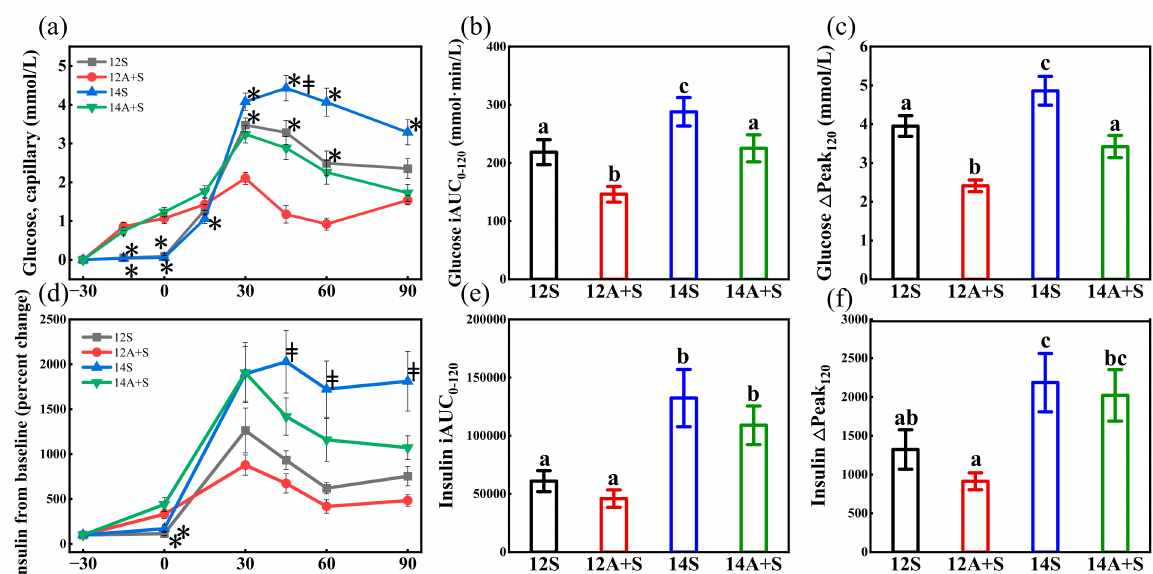
Figure 3. Postprandial capillary glucose responses and parameters ( a – c ), postprandial capillary